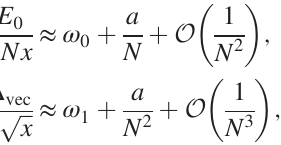
. The errors represent the max